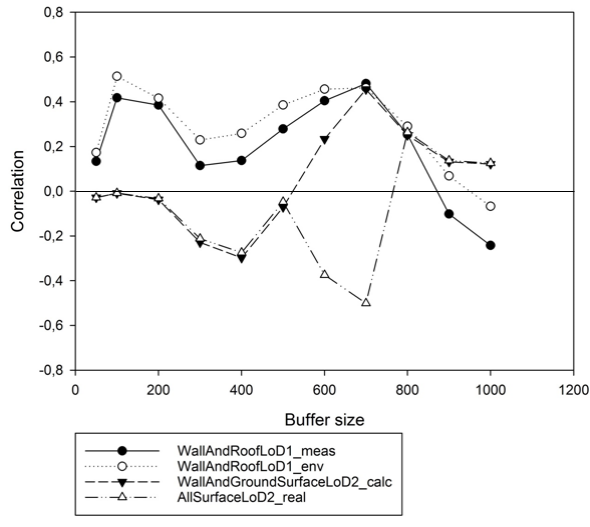
Figure 14. Correlation coefficient of different wall and roof surface calculations with the measured TNC values in different buffer